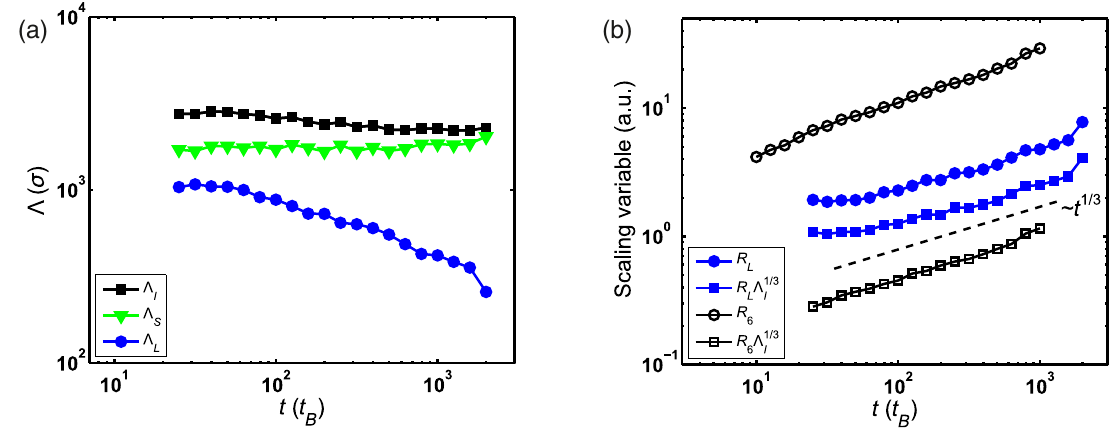
, Λ , and Λ , in units of particle diameters. I S L Λ 1 = 3 behaves as L I . The L